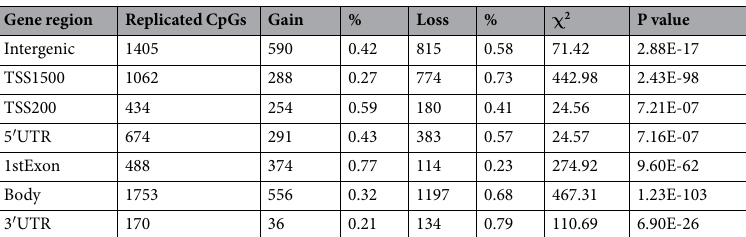
Table 2. Proportion of age-methylated (gain) and demethylated (loss) CpG in each